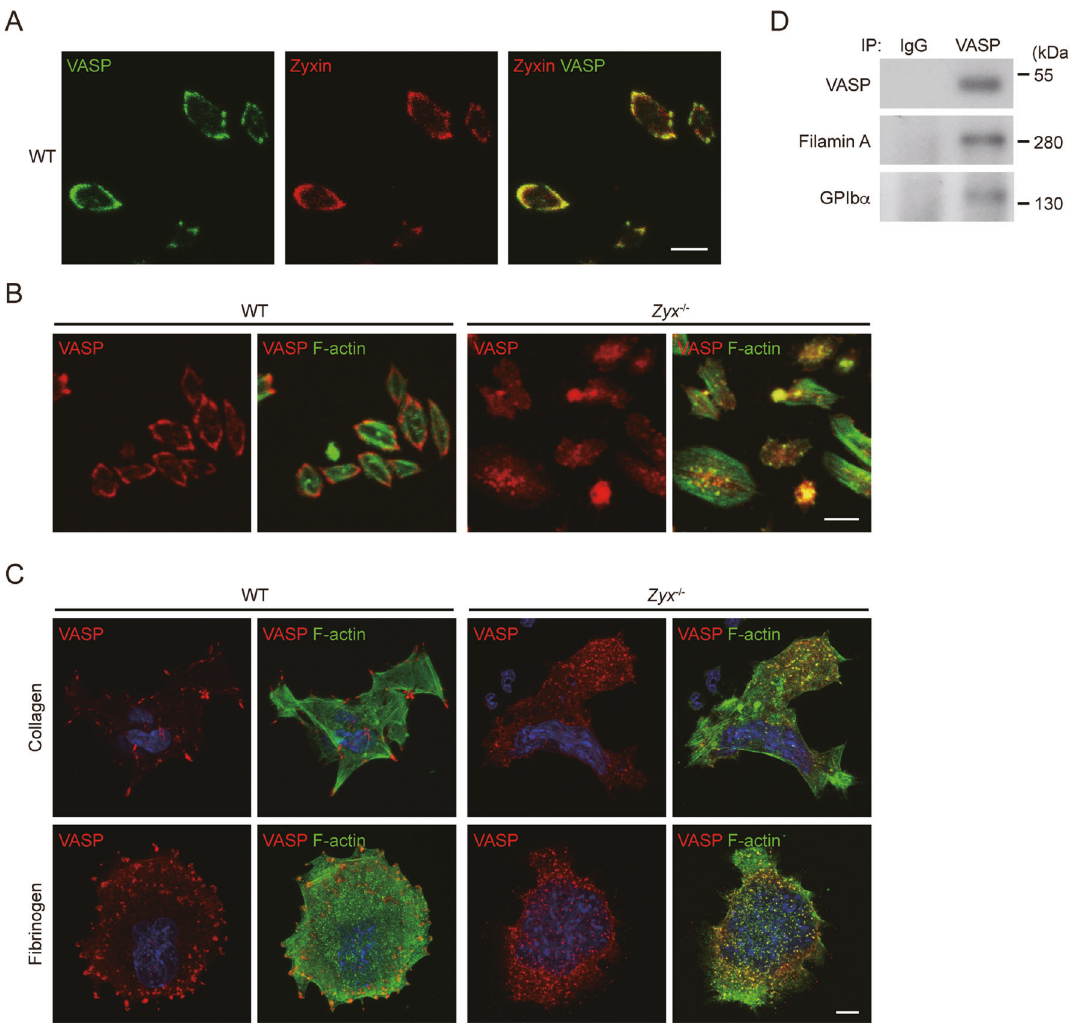
Fig. 6 Zyxin de fi ciency affects VASP localization. A, B Platelets were allowed to spread on fi brinogen in the presence of thrombin. Representative confocal images of spread WT platelets stained for VASP (green) and zyxin (red) ( A ). Representative confocal images of spread WT and Zyx − / − platelets stained for and VASP (red) and F-actin (green) ( B ). Scale bar: 5 μ m. C Representative confocal images of WT and Zyx − / − FL HPC-derived MKs allowed to spread on type I collagen and fi brinogen and stained for VASP (red), F-actin (green), and nuclei (blue). Scale bar: 10 μ m. The original magni fi cation of all the images is ×630. Results are representative of fi ve independent experiments. D Filamin A and GPIb α were co-immunoprecipitated with VASP by anti-VASP antibody in WT platelet lysate. Results are representative of fi ve independent